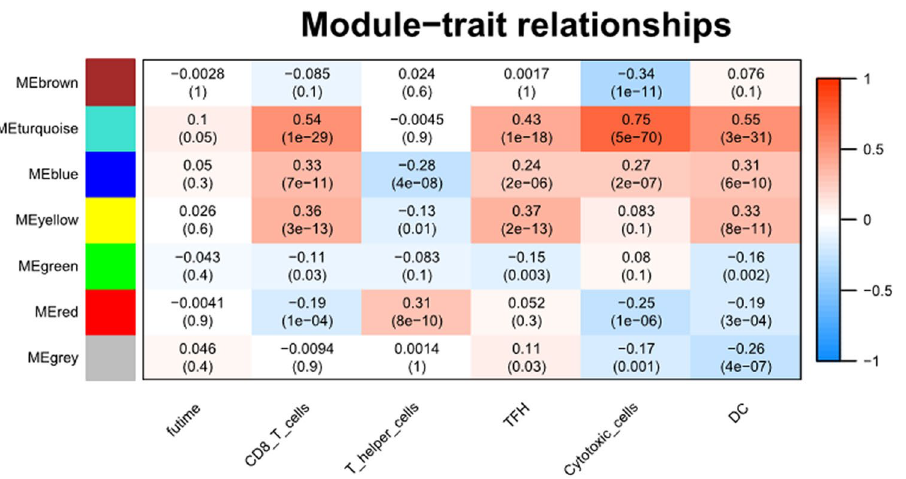
Figure 1. Identification of key module associated with the prognostic immune cells through WGNCA by module-trait heatmap. Each cell contains correlation and p value. Each column represents a trait. The module name is shown to the left side of each cell. Each module represents a cluster of densely interconnected genes in terms of co-expression.